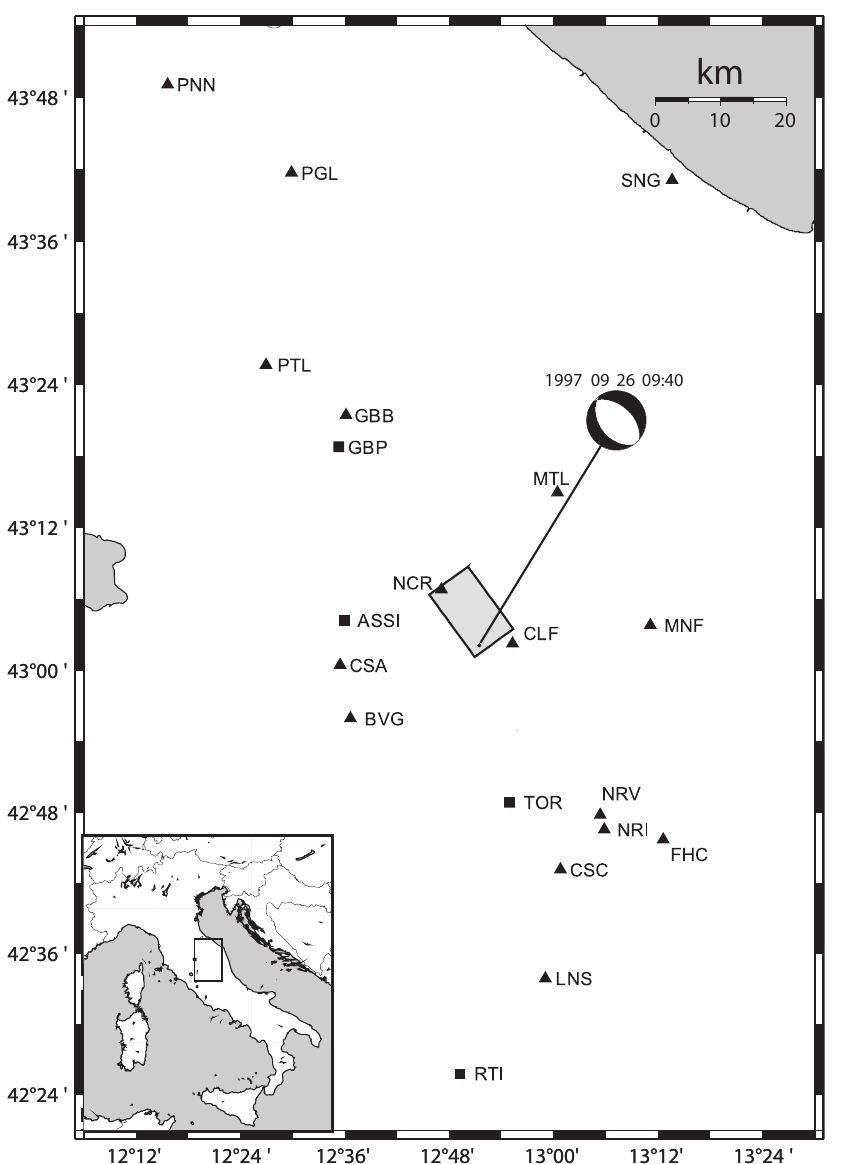
Fig. 3. Strong motion stations that recorded the Colfiorito earthquake (ASSI: Assisi, BVG: Bevagna, CLF: Colfiorito, CSA: Castelnuovo di Assisi, CSC: Cascia, FHC: Forca Canapina, GBB: Gubbio, GBP: Gubbio pi- ana, LNS: Leonessa, MNF: Monte Fiegni, MTL: Matelica, NCR: Nocera Umbra, NRI: Norcia zona industriale, NRV: Norcia Altavilla, PGL: Pegli, PNN: Pennabilli, RTI: Rieti, SNG: Senigallia, TOR: Cerreto Torre). Trian- gles and squares correspond to digital and analog seismic stations, respectively. The fault surface projection (grey rectangle) and the focal mechanism of the Colfiorito earthquake, shown in the figure are from Capuano et al .